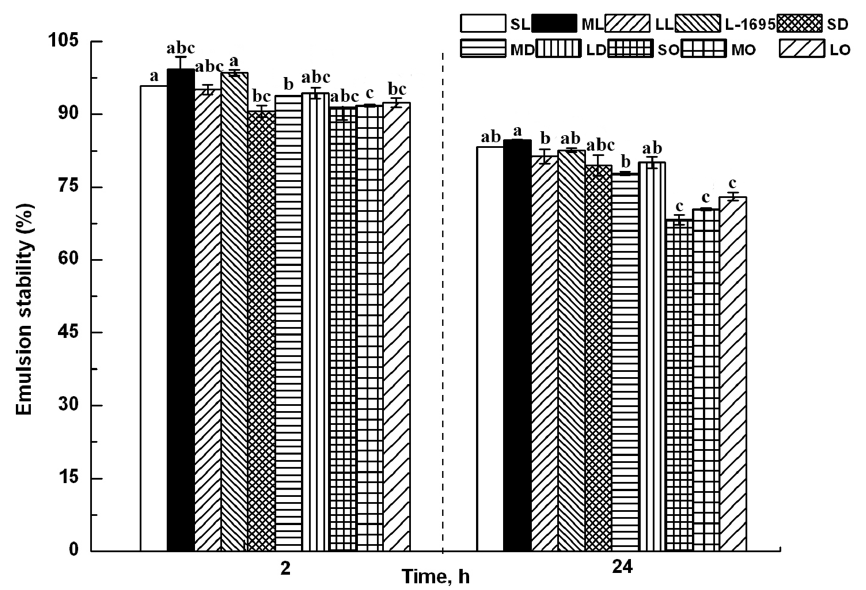
Fig. 5. Emulsion stability of sugar esters in 0.02% (w/v) aqueous solution at 25 ˚ C. Different letters represent significant difference ( p , 0.05).